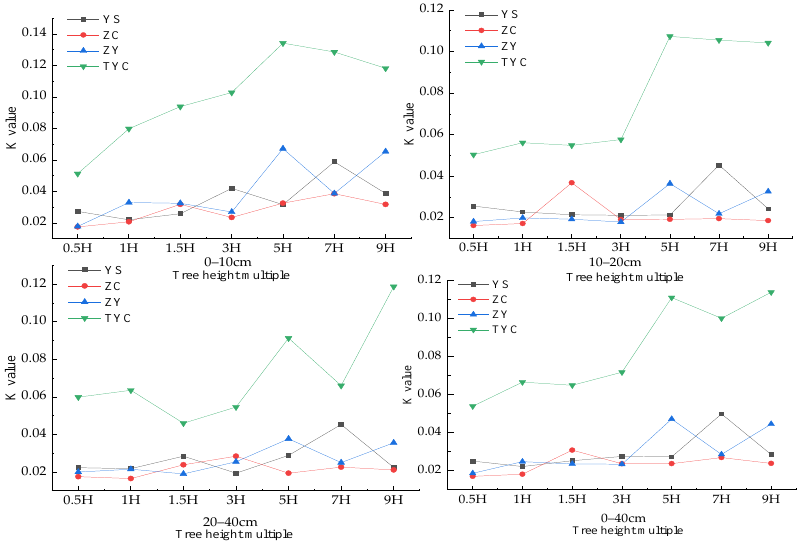
Figure 9. Change in soil erodibility K values at different distances from shelterbelts.